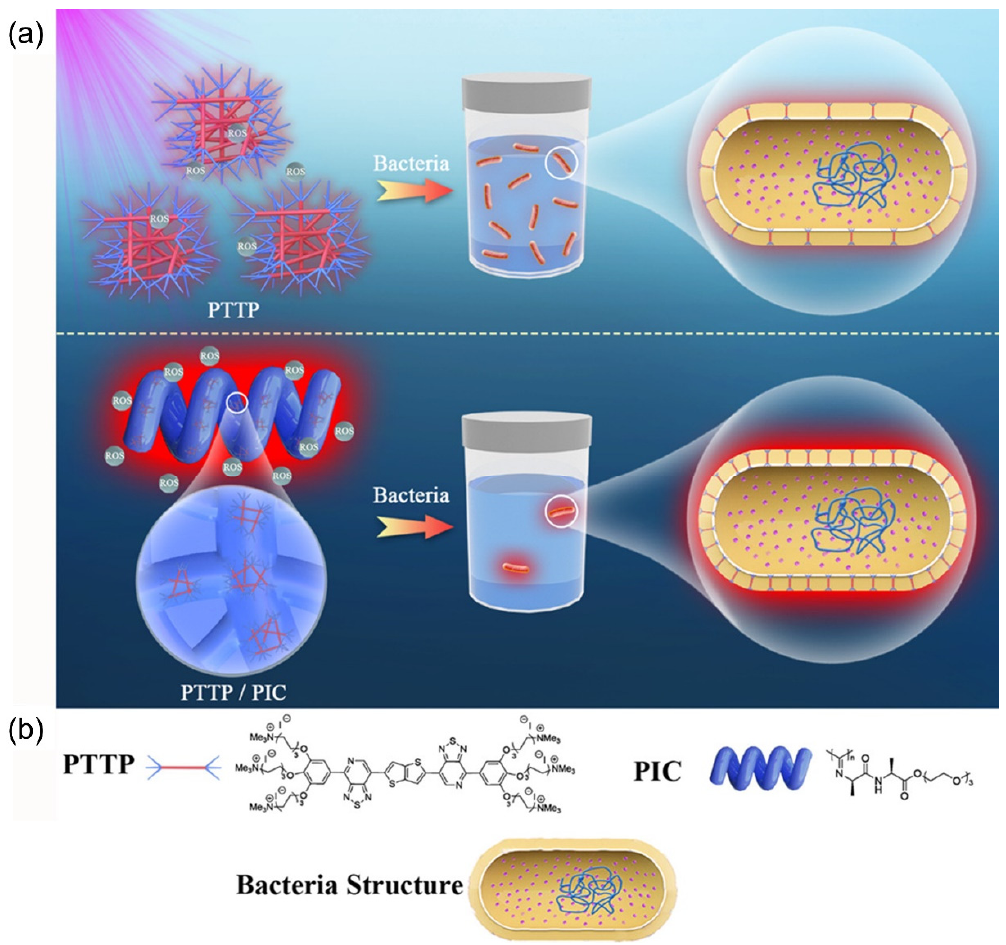
Figure 6. Illustration of PTTP itself and PIC/PTTP composite biomimetic hydrogel combined with pathogenic bacteria ( a ) and chemical structure of PTTP and PIC ( b ). Reprinted with permission from Ref. [37]. Copyright 2021 American Chemical Society.